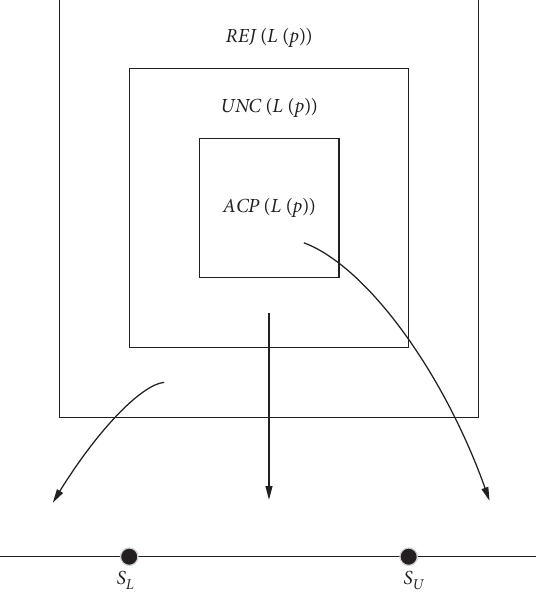
Figure 3: The three regions divided by the PL3W-MADM